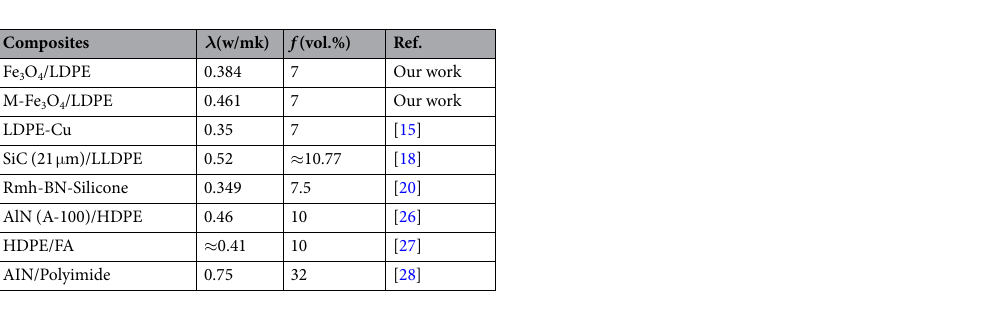
Table 1. Comparison of the thermal conductivity of our composites and reported literature